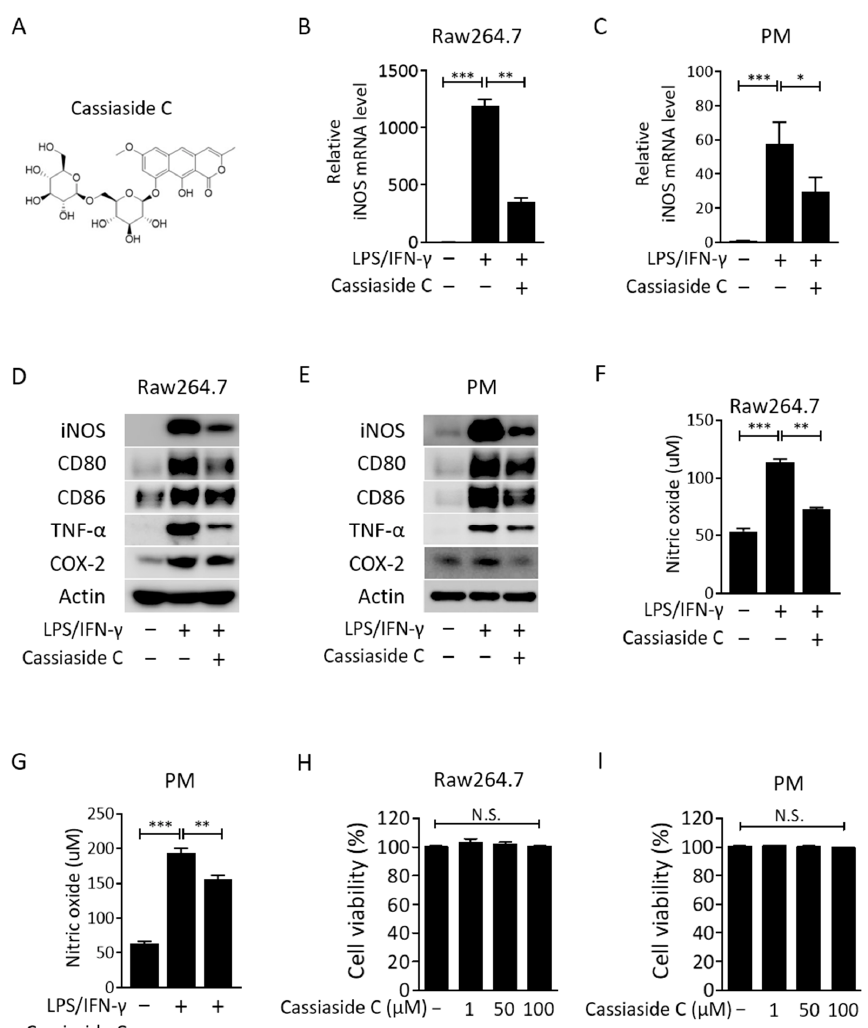
Figure 1. Cassiaside C inhibits M1 macrophage polarization. ( A ) Chemical structure of Cassiaside C. ( B , C ) Effects of Cassiaside C on iNOS mRNA expressions in LPS/IFN- γ -stimulated Raw264.7 cells and PMs. ( D , E ) Effects of Cassiaside C on levels of iNOS, CD80, CD86, TNF- α , and COX-2 in LPS/IFN- γ -stimulated Raw264.7 cells and PMs. ( F , G ) Effects of Cassiaside C on NO concentrations in LPS/IFN- γ -stimulated Raw264.7 cells and PMs. ( H , I ) Effects of Cassiaside C on cellular viability in LPS/IFN- γ -stimulated Raw264.7 and PM cells. Data are expressed as the mean ± SEM ( n = 3 technical replicates). N.S., not significant; * p < 0.05, ** p < 0.01, and *** p < 0.001. PM, peritoneal